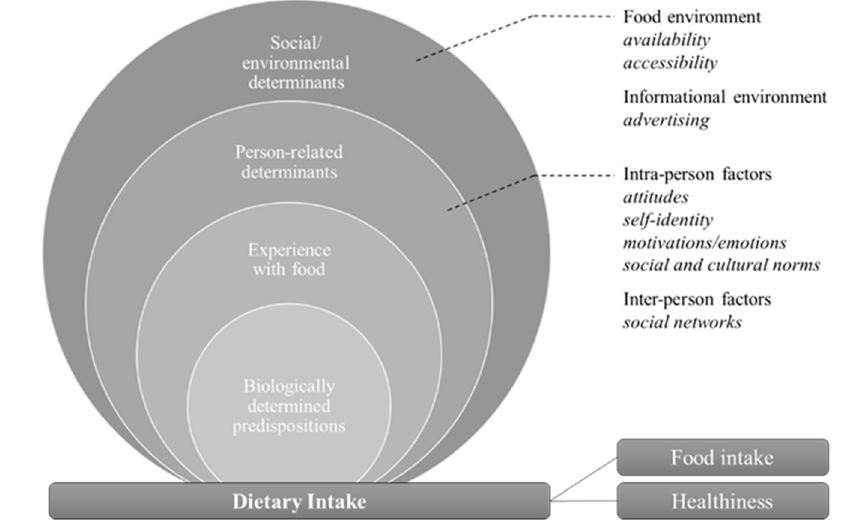
Figure 4. Food behavior variables of analog dietary intake linked to digital food communication. (adapted from Contento and Koch, 2021, p. 50).